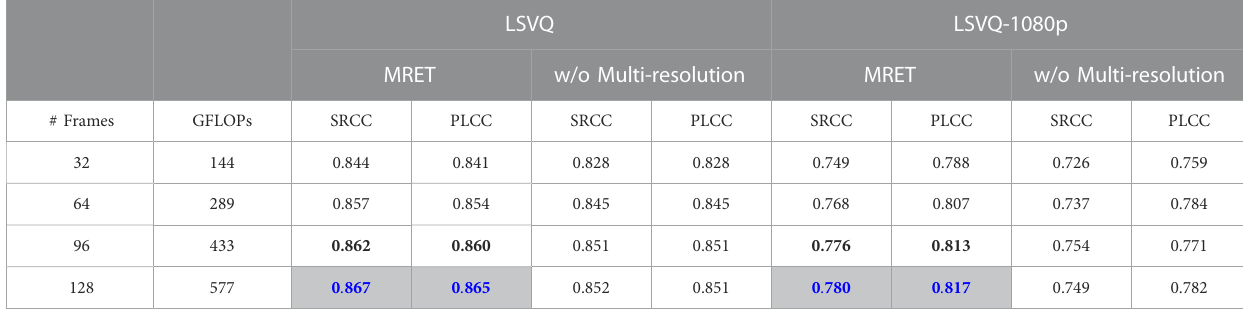
TABLE 3 Ablation study results for multi-resolution input on LSVQ and LSVQ-1080p dataset. MRET uses multi-resolution input while “ w/o Multi-resolution ” uses fi xed-resolutionframes.Bothmodelsgroupedtheframesby N =4whenencodingvideoframesintotokens.Blueandblacknumbersinboldrepresentthebestand second best respectively on the same dataset. Our fi nal method is marked in gray.